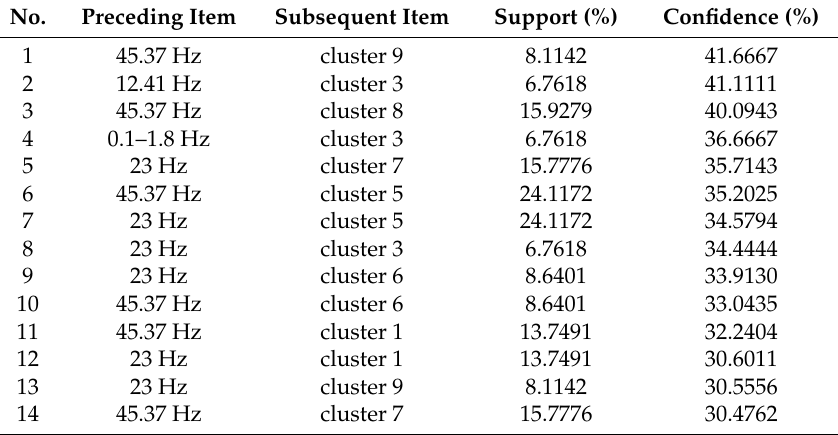
Table 10. Association rules of 1500 data